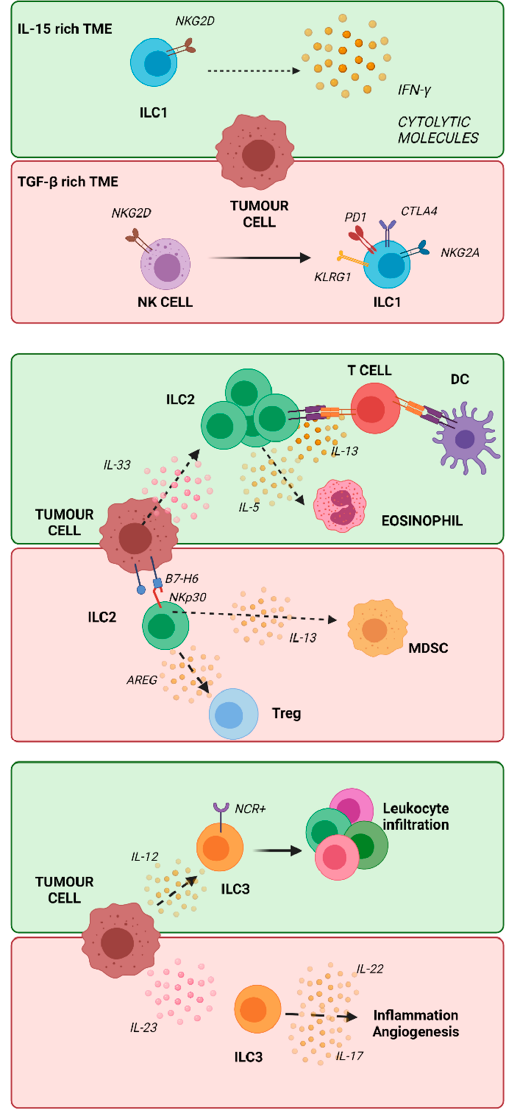
Figure 1. Helper ILCs and their role in cancer development/regression. The illustration summarizes the different roles of helper ILCs in cancer. In green, it has been reported how ILC1s, ILC2s or ILC3s could be helpful in terms of cancer control; in red, how they can be harmful and support cancer progression or promotion. Some of the pathways represented in this illustration were described in Crinier et al., 2019 [89]. In an IL-15-rich TME, ILC1s can produce lytic molecules, contributing to tumor cell elimination. However, TGF- β causes a transition from NK cells to ILC1s, which are less cytotoxic; this mechanism may sustain tumor growth/progression. Considering ILC2s, they can help tumor regression by recruiting T cells and eosinophils; on the other side, through IL-13 production, they can recruit MDSCs and through AREG and Tregs they contribute to the establishment of an immune-suppressive environment. ILC3s can contribute to tumor regression by inducing leukocyte infiltration through IL-12 release; on the other hand, they can exert a pro-tumor role through the production of IL-17/IL-22 under the influence of IL-23 produced by the tumor. (Created with BioRender.com).